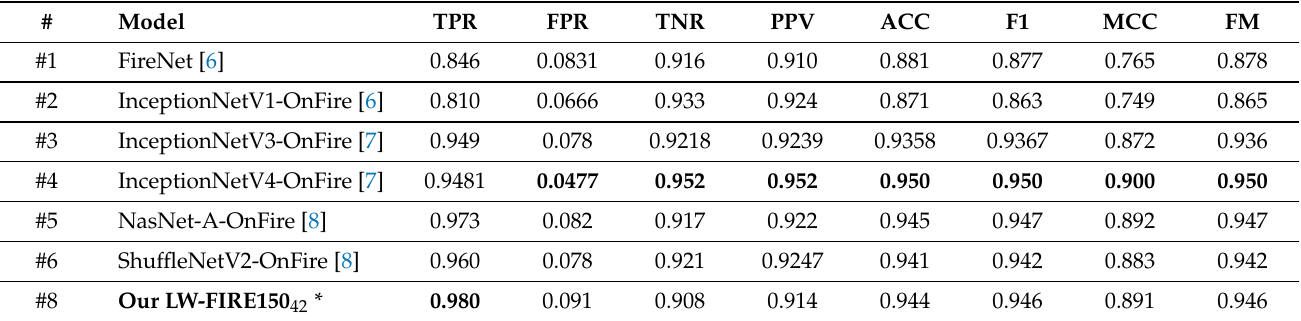
Table 6. Comparison with the state of the art on the dataset presented in [6]. Our model was not trained on this dataset, though other models have been trained and tested on this dataset. * Evaluated on 2 × 2 tiles of images in this dataset (as presented in Figure 8).